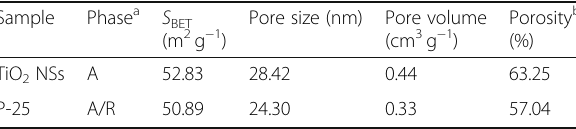
Table 1 Comparison of the various physical properties of the TiO 2 NSs and P-25 photoanodes